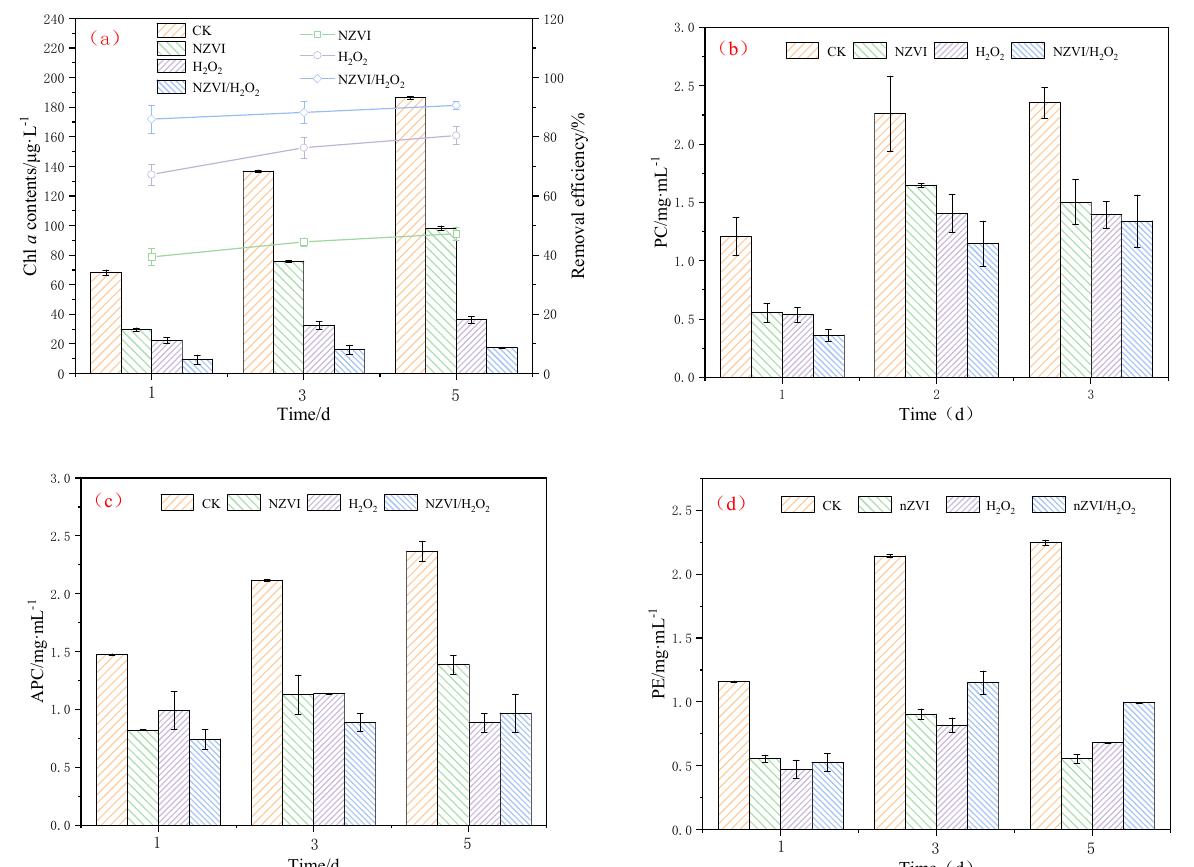
Figure 1. Combined effect of NZVI and H 2 O 2 on the growth of M. aeruginosa for ( a ) Chl a contents; ( b ) PC contents; ( c ) APC contents; and ( d ) PE contents. Mean ± standard deviation of three replicates is shown for each value.